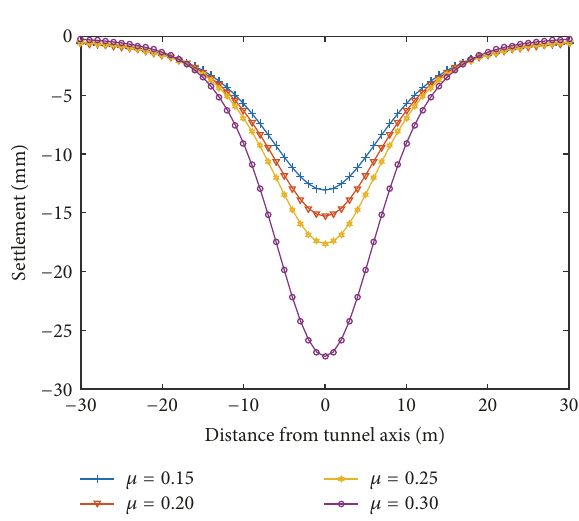
Figure 4: Influence of 𝜇 on surface settlement.